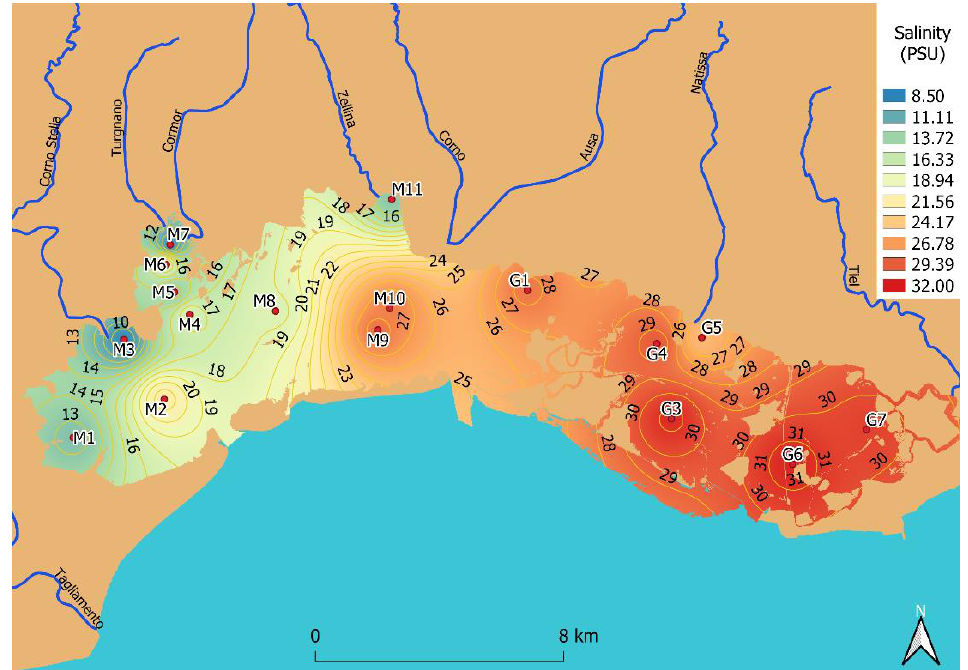
Figure 5. Spatial distribution of salinity (average of all collected data from 2013 to 2020) obtained by IDW (Inverse Distance Weighted) interpolation.